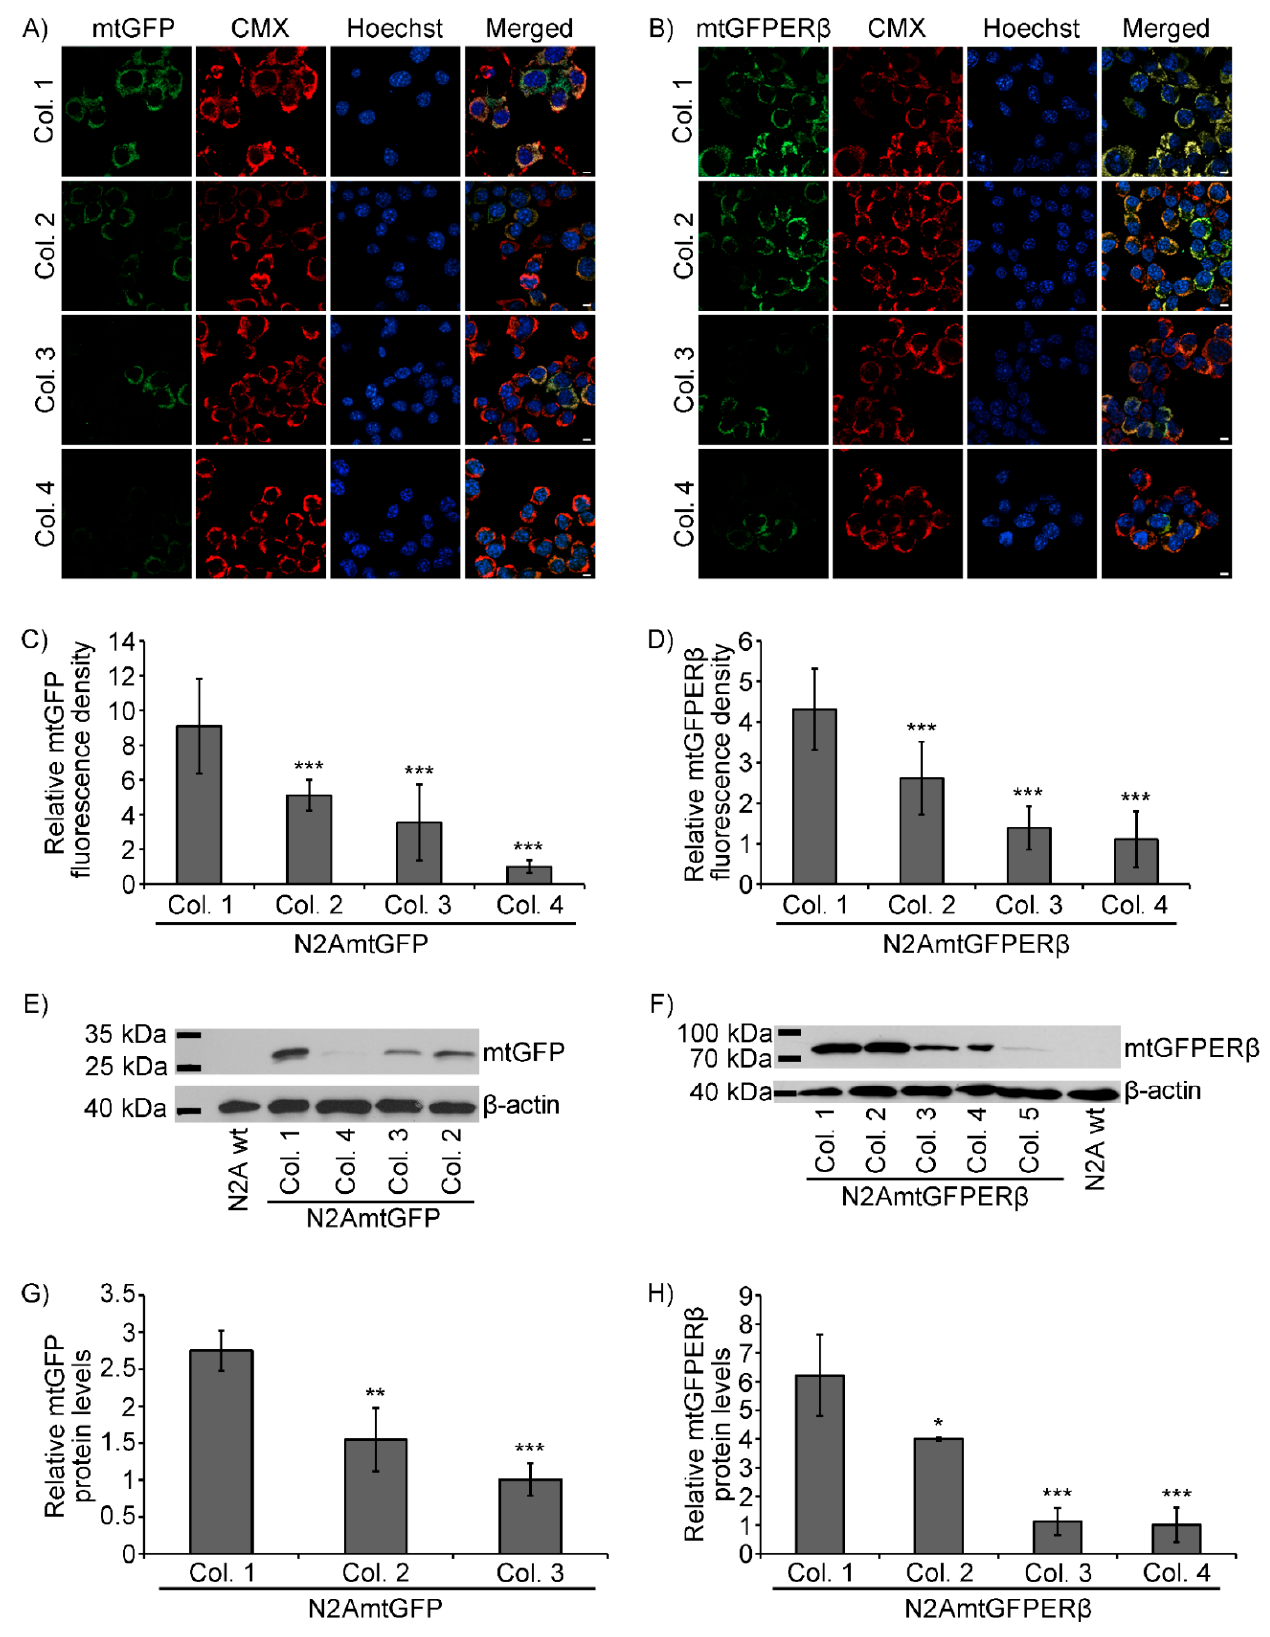
Figure 1. Characterization of the N2AmtGFP, N2AmtGFPER β stable cell lines. Confocal microscopy analysis for the as- sessment of the GFP expression levels in colonies of the N2AmtGFP ( A ) and N2AmtGFPER β , ( B ) cells and its colocaliza- tion with the CMX mitochondrial dye. Hoechst staining was applied for nuclear staining. Bars indicate 10 μ m. Quantifi- cation of the relative expression levels of the mitochondrial green fluorescence protein in colonies of the N2AmtGFP and